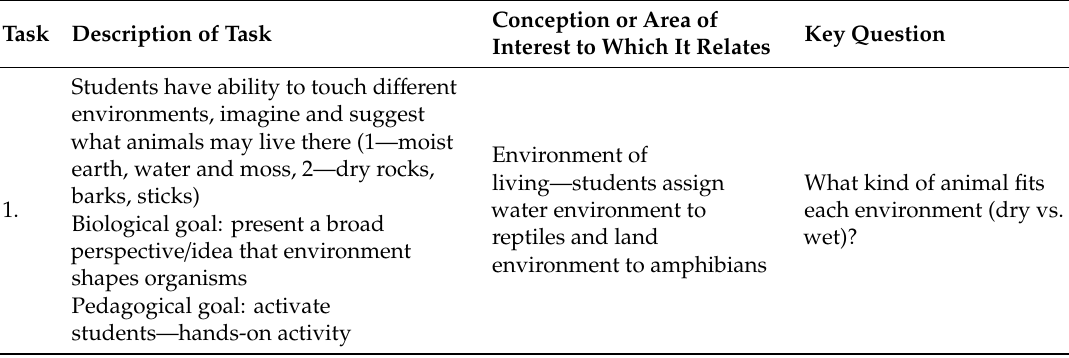
Table 5. Tasks designed for teaching sequence, on the base of conception or area of interest to which it relates and key questions which were asked during conducting the